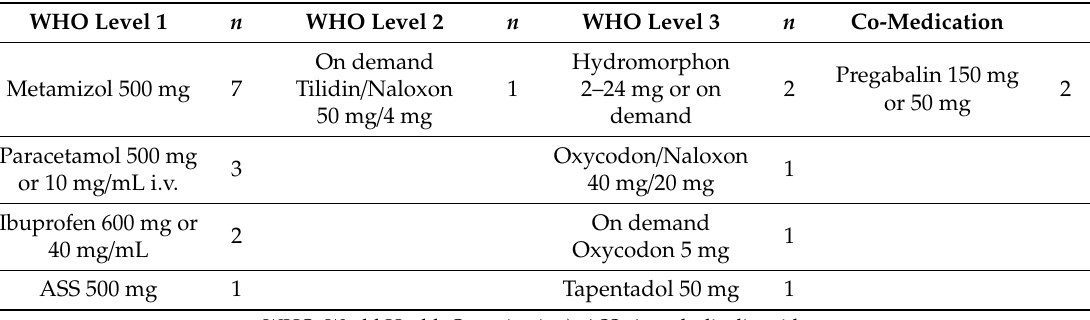
Table 2. Pain medication at the time of discharge from the hospital.